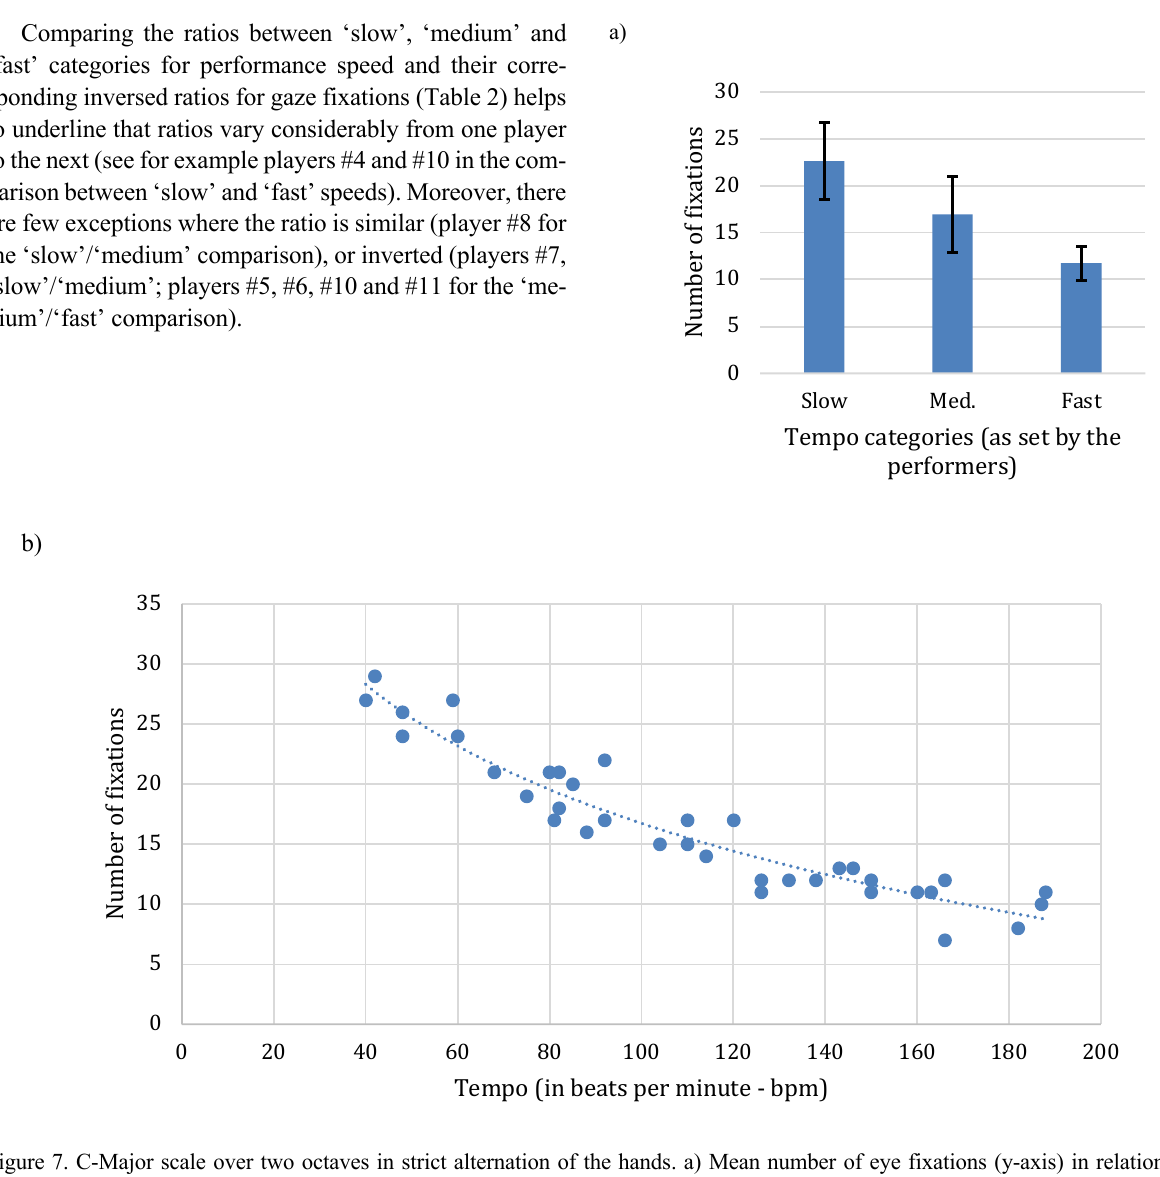
Figure 7. C-Major scale over two octaves in strict alternation of the hands. a) Mean number of eye fixations (y-axis) in relation to tempo conditions (x-axis: Slow, Medium, Fast) according to performers’ preferences; error bars represent the standard deviation. b) Number of eye fixations (y-axis) in relation to performance tempo across all trials, in beats per minute